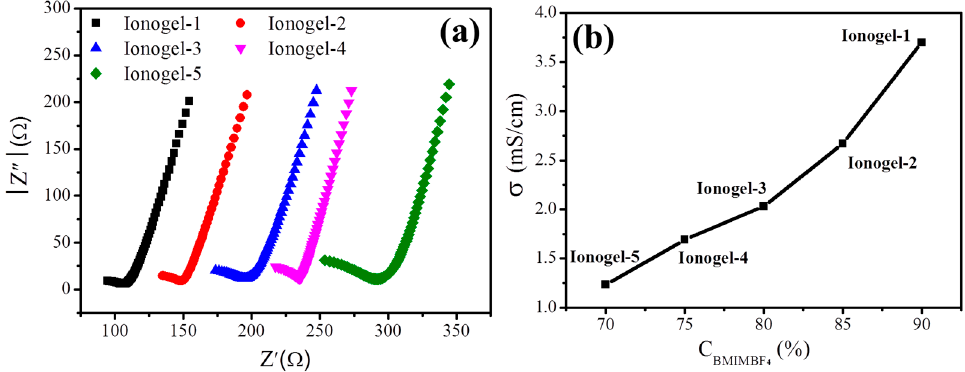
Figure 5. (a) The impedance plots of ionogels; ( b ) changes of ionic conductivity as functions of polymer.